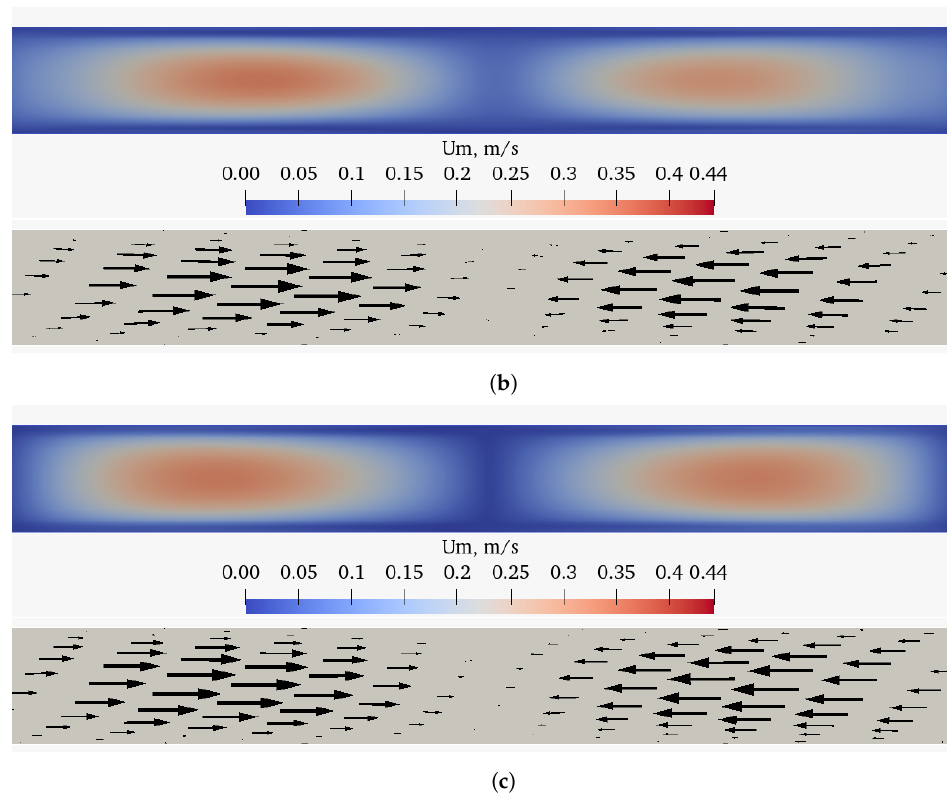
Figure 11. Velocity magnitude and vectors of streaming on the 2D cross-sections ( xz planes) of the 3D resonator for y = ( 0.5,0.375,0.125 ) H. ( a ) xz plane at y = 0.5 H. ( b ) xz plane at y = 0.375 H. ( c ) xz plane at y = 0.125 H.